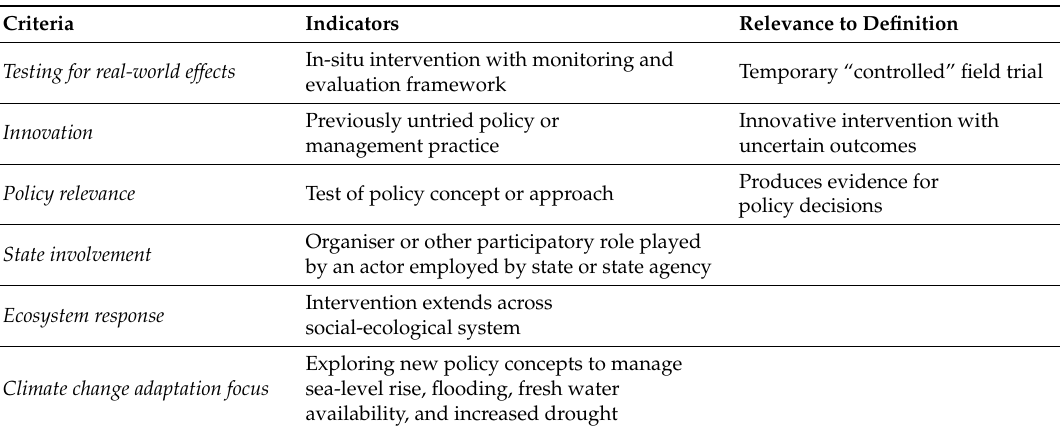
Table 4. Criteria and associated indicators used to identify policy experiments in climate change adaptation in the